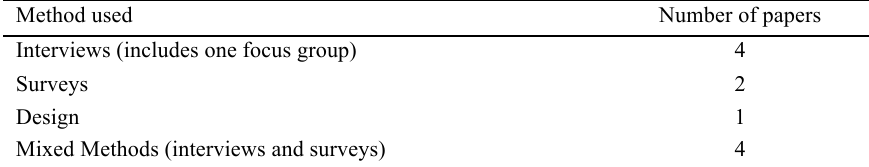
Table 4. Breakdown of empirical studies in the 20 most cited papers between 1999 and 2014 Method used Number of papers Interviews (includes one focus group) 4 Surveys 2 Design 1 Mixed Methods (interviews and surveys) 4